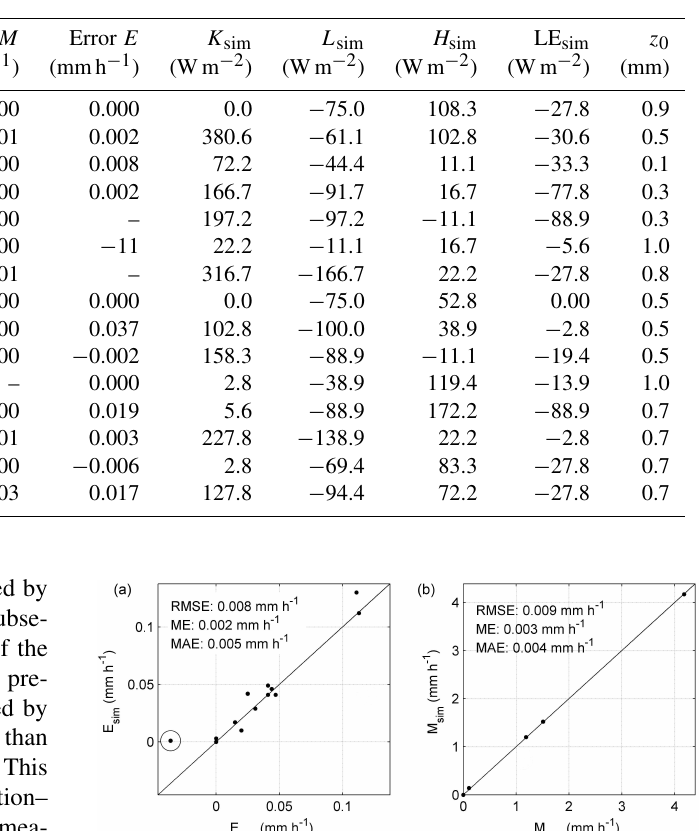
Table 4. Summary of the simulated (sim) results ( M , melting; E , evaposublimation; C , deposition–condensation) from the energy balance model for each data set period, together with the simulated energy flux terms (shortwave radiation, K ; longwave radiation, L ; sensible-heat exchange, H ; latent-heat exchange, LE) and the calibrated values for the model parameters (roughness length, z 0 ; constant sensible-heat transfer coefficient in windless conditions, K H0 = 1Wm − 2 K − 1 ).